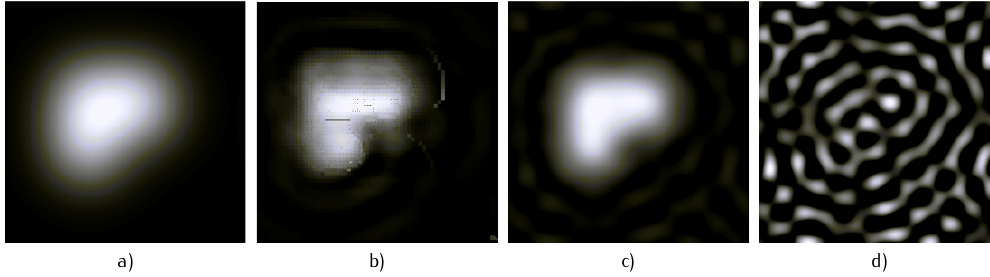
Figure 3. Test 2. Efficiency of the application of the adaptive mesh refinement for calculation of the deconvolution function z Simulated backscattered data u ( ξ,η ) . b) Computed deconvolution function z α on the adaptively refined mesh with the regularization parameter α = 2e10 − 7 . c), d) Computed deconvolution function z α on the uniform mesh with the regularization parameters α = 0 . 01 and α = 2e10 − 7 ,